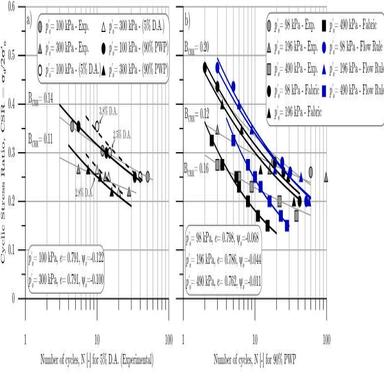
Cyclic strength curves and simulations for: a) Toyoura sand, and b) El Torito tailings sand.